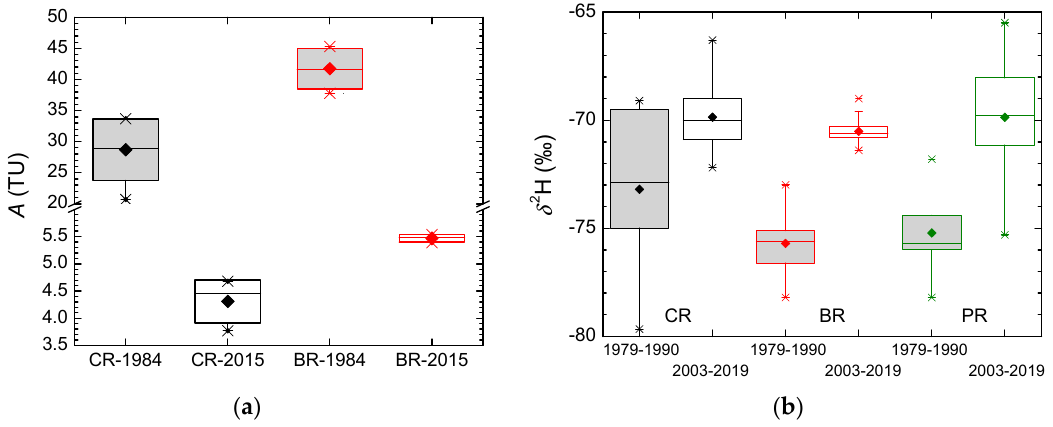
Figure 9. ( a ) Comparison of the tritium activity concentration in the Crna Rijeka (CR) and Bijela Rijeka (BR) springs in 1984 and 2015; ( b ) comparison of the δ 2 H values in the CR, BR, and Plitvica River (PR) springs in the two periods, 1979–1990 and 2003–2019.